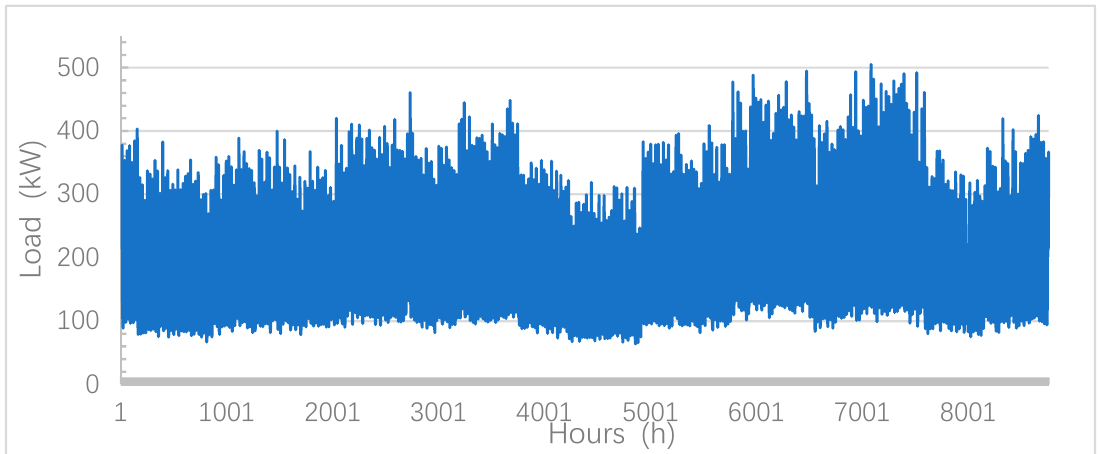
Figure 10. Annual load demand of the studied location.